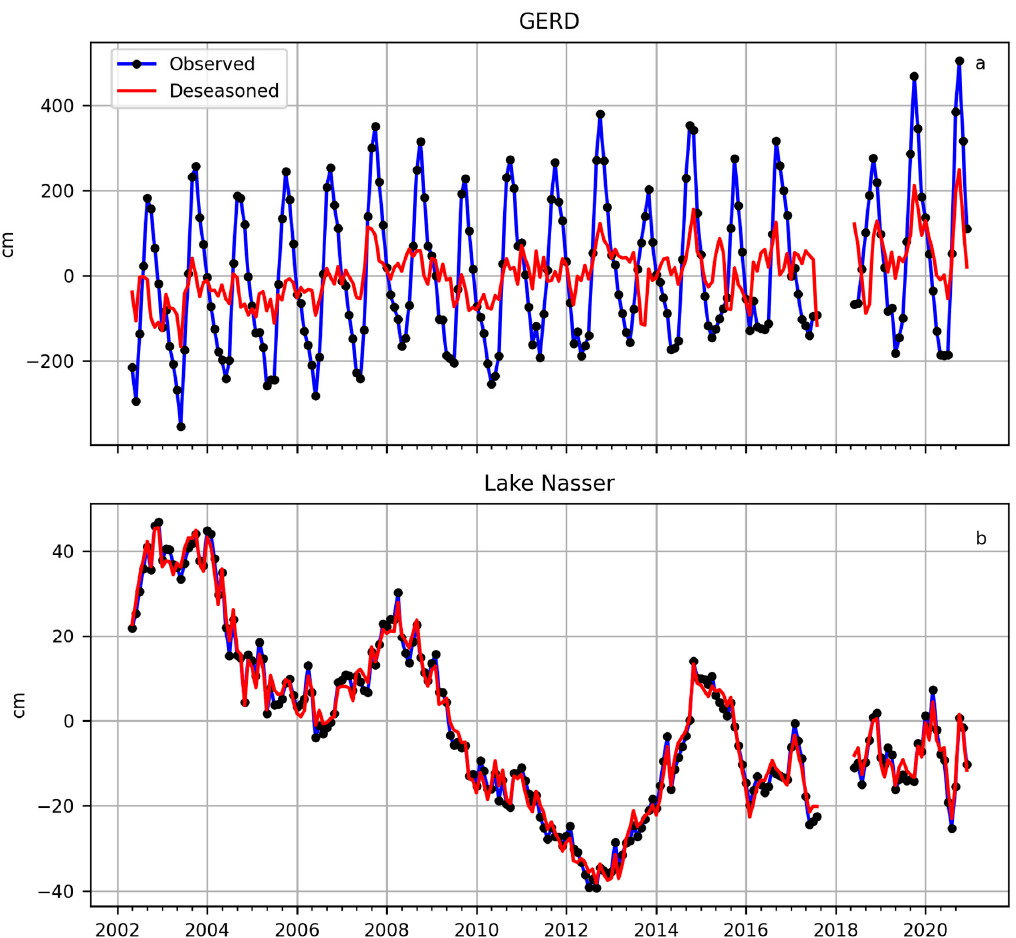
Figure 7. ( a , b ) Total water anomaly derived from the Gravity Recovery and Climate Experiment (GRACE) liquid water equivalent (LWE) data for GERD and Lake Nasser. These time-series correspond to the single pixel where GERD and Lake Nasser are located. The GRACE anomalies normalized for the baseline of 2002–2020.